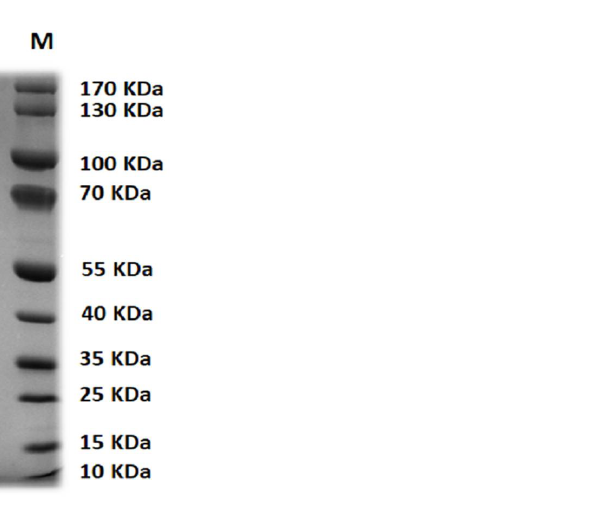
Figure 2. SDS-PAGE analysis of phage structural proteins. Lane M, protein marker. Lanes 1–4, structure proteins from STEC P1–STEC P2.